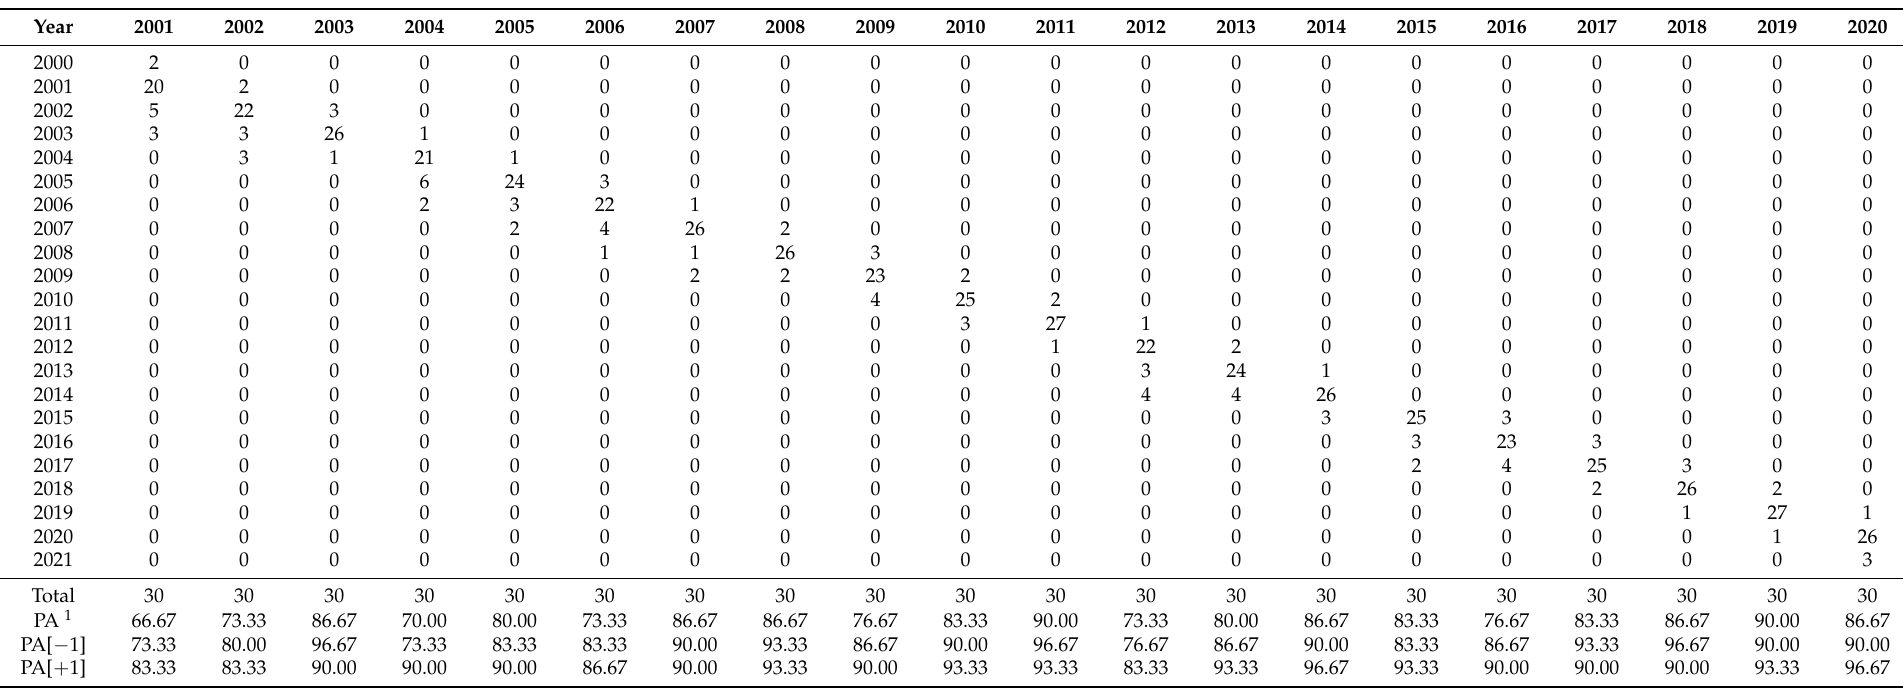
Table 4. The accuracy of the disturbance year accomplished by selecting 30 shale oil/gas well samples in Eagle Ford each